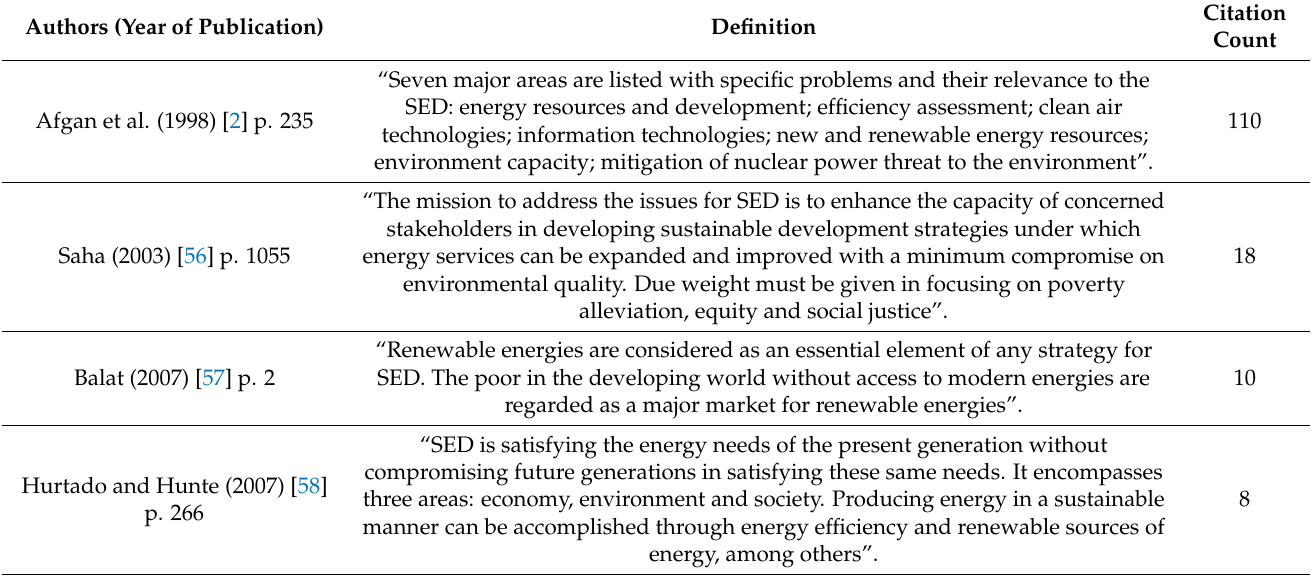
Table 3. Definitions of the SED (Note the definitions are presented in chronological